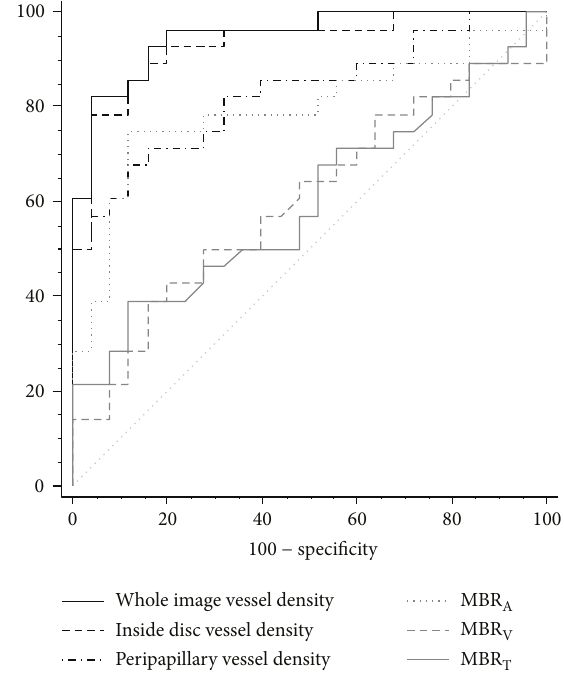
Figure 2: Receiver operating characteristic curves for OCT-A whole image vessel density, inside disc vessel density, peripapillary vessel density, and LSFG MBR , MBR , and MBR . OCT-A =optical A T V coherence tomography angiography; LSFG =laser speckle fl owgraphy; MBR =mean blur rate inside the whole optic nerve A head area; MBR =mean blur rate of the tissue area inside the T optic nerve head; MBR =mean blur rate of the vessel area inside V the optic nerve head